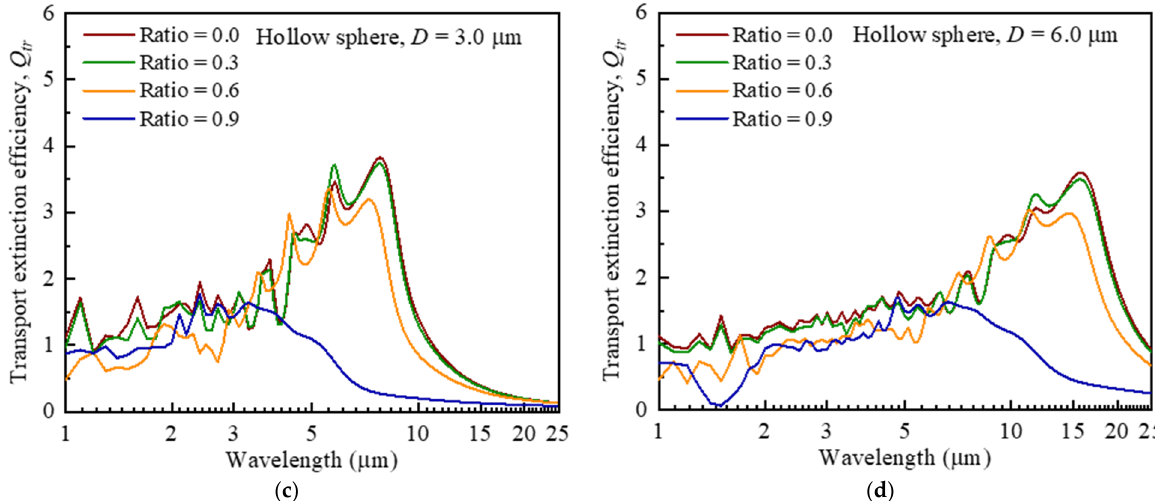
Figure 3. Influence of shell thickness on the extinction efficiency and transport extinction efficiency of hollow sphere. ( a ) Extinction efficiency vs. wavelength, where the outer diameter is 3.0 µm, ( b ) extinction efficiency vs. wavelength, where the outer diameter is 6.0 µm, ( c ) transport extinction efficiency vs. wavelength, where the outer diameter is 3.0 µm, and ( d ) transport extinction efficiency vs. wavelength, where the outer diameter is 6.0 µm.